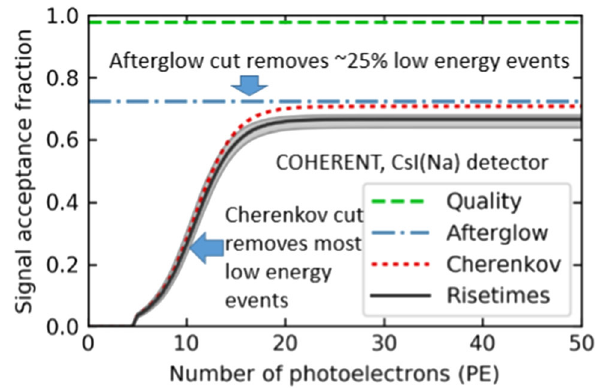
Fig. 13 Detection efficiency of low energy events after each event selection criterion of the COHERENT CsI(Na) detector, adopted from Ref. [2]. Cherenkov cut removes most of the events near